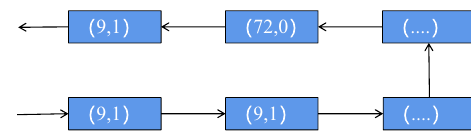
Figure 3: The structure of the taboo